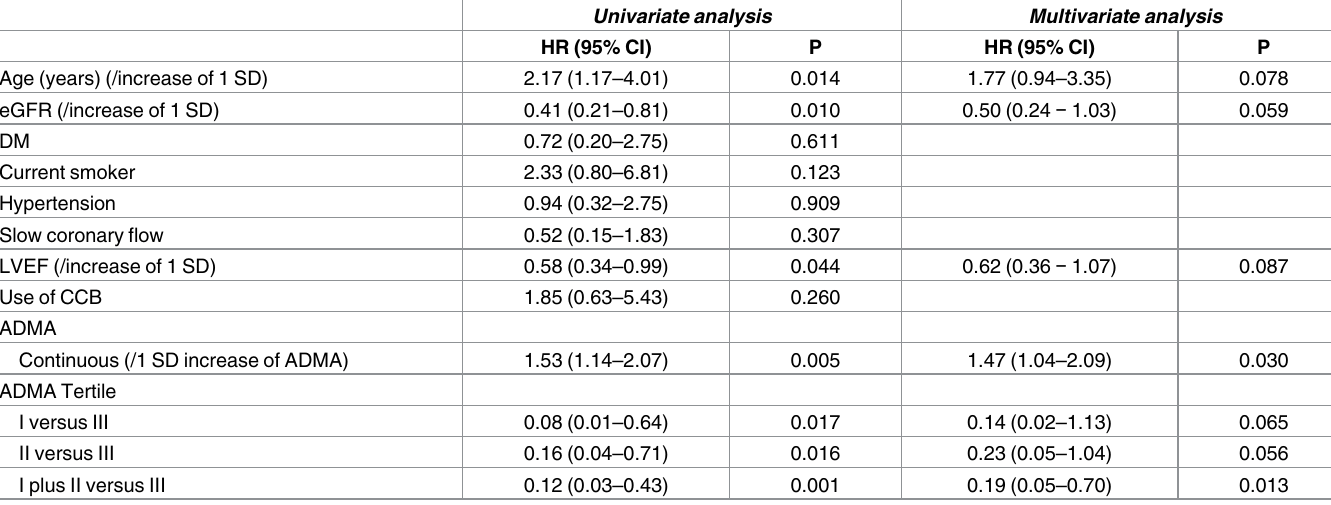
Table 2. Univariate and multivariate Cox regression analysis for